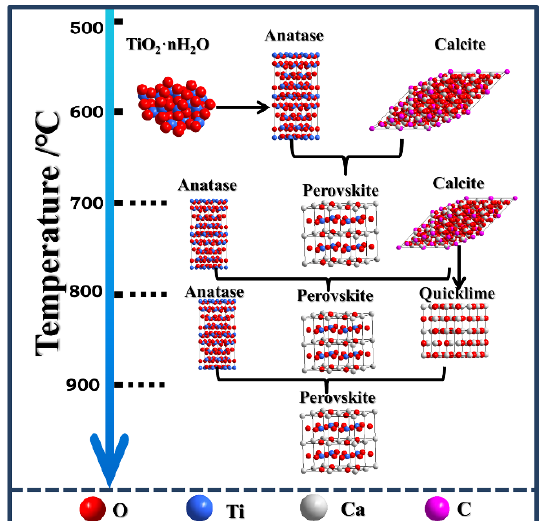
Figure 2. Schematic diagram of perovskite phase transformations during the synthesis of SPP.